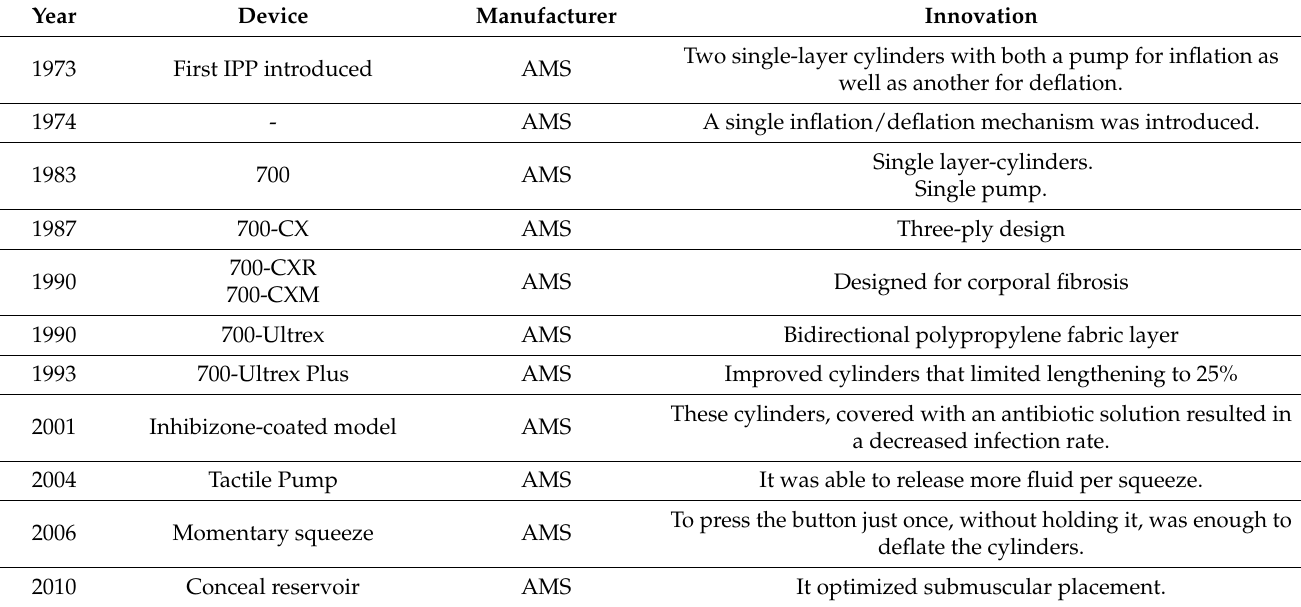
Table 1. The updates of penile prosthesis introduced by